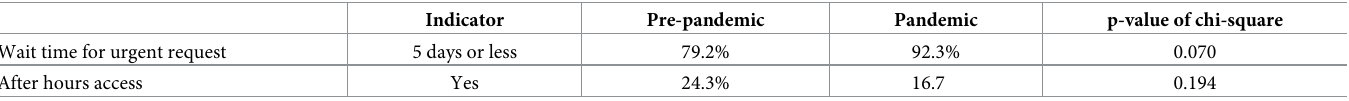
Table 3. Timely access to primary care indicators pre-pandemic and during the COVID-19 pandemic ( n = 114). Indicator Pre-pandemic